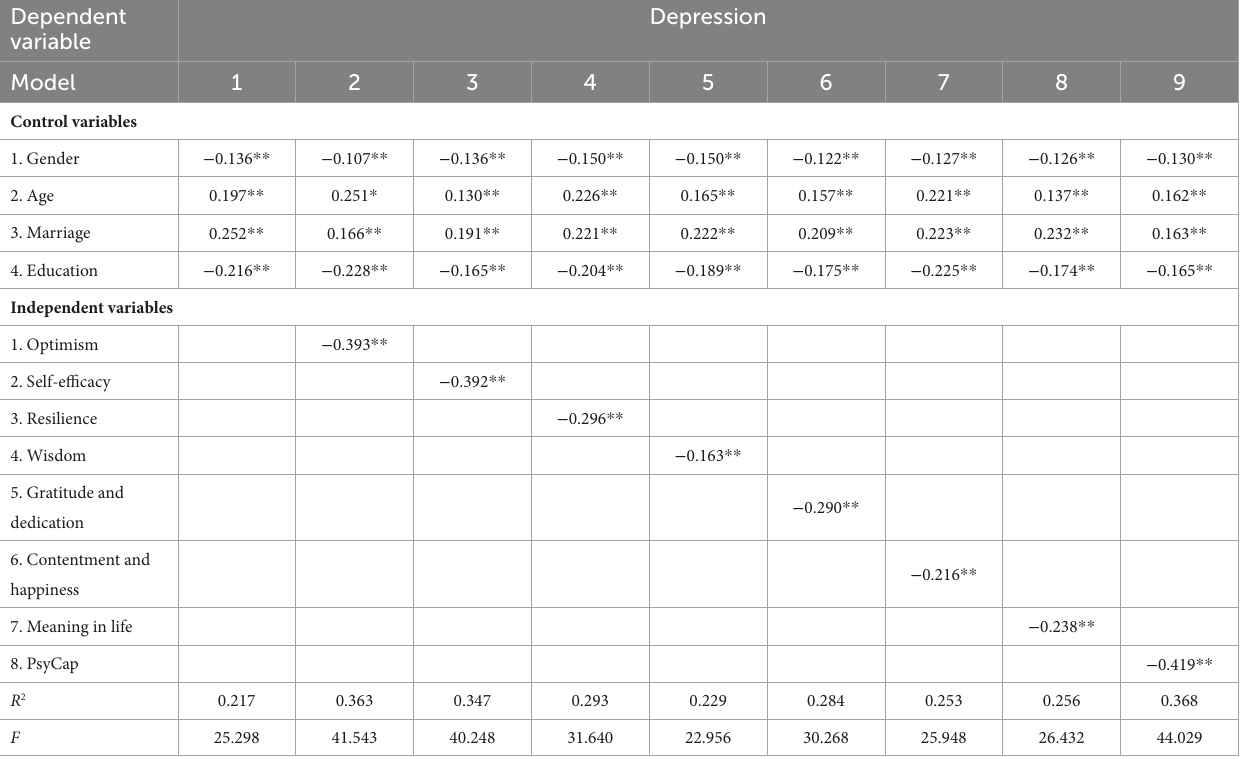
TABLE 8 Relationships between PsyCaps and depression ( N = 328). Dependent